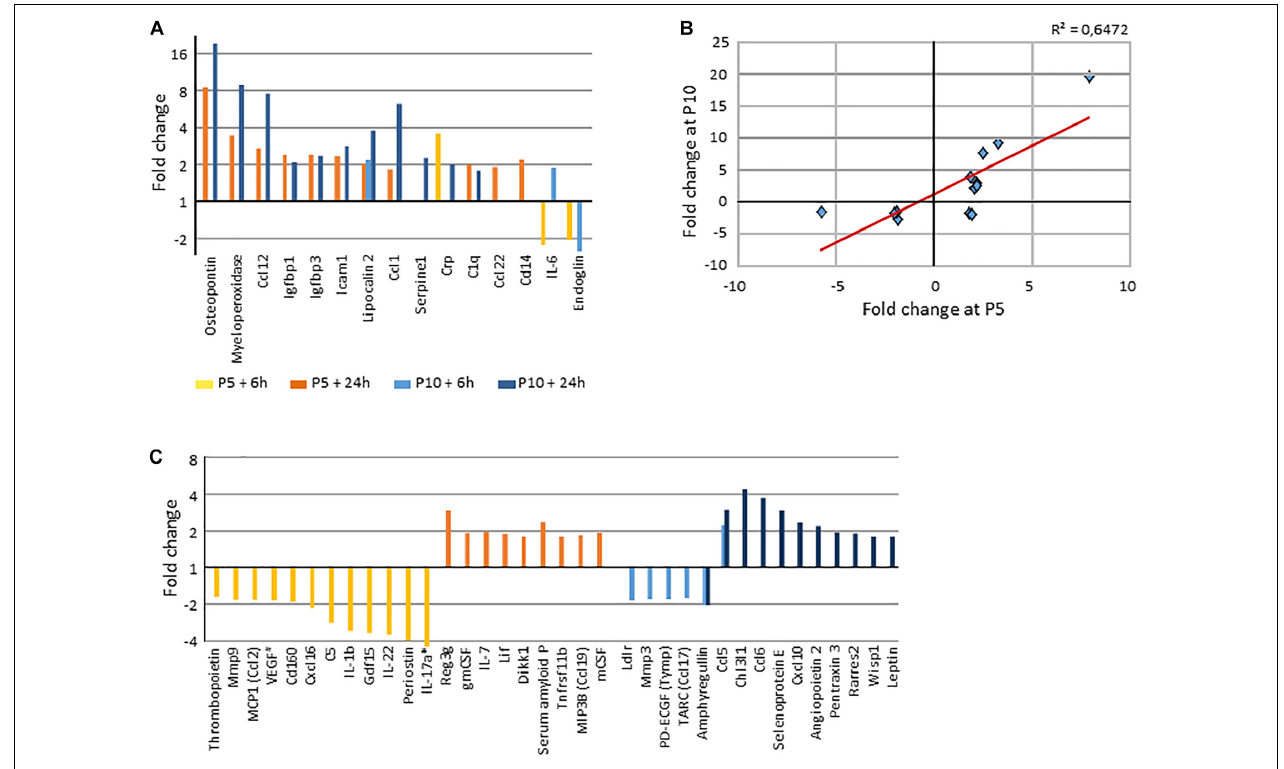
FIGURE 10 | Protein array determination of HI induced variation by a minimum 1.75x in both senses. (A) Common proteins regulated by HI at P5 and P10 ( > | 1.75x | ), in both senses (decreases noted as negative values). (B) Correlation of fold changes of proteins affected by HI at the two ages. (C) Age dependent regulated proteins ( > | 1.75x | ). *, IL17a in P5 mice 6 h after HI was decrease by 8.35x, # , VEGF pattern is detailed in Supplementary Material